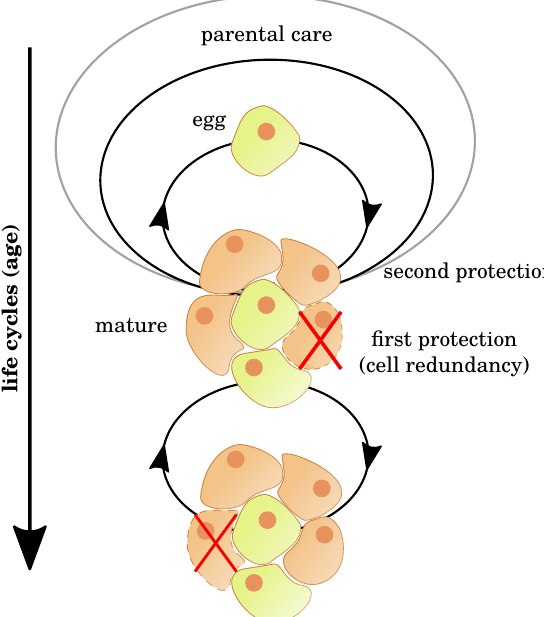
Figure 1. Cell lines can protect themselves against damage. With ongoing life cycles, cells divide and progress intro mature cells. That process differs in the speed and number of cells depending on the tissue type. Cells in multicellular organisms can be protected by neighbouring cells (orange) and other individuals (parental care and broader). Damage, however, is not avoidable and causes the death of single cells (crossed out), but the cell line itself survives and stays robust. In theory, all germ cells could live